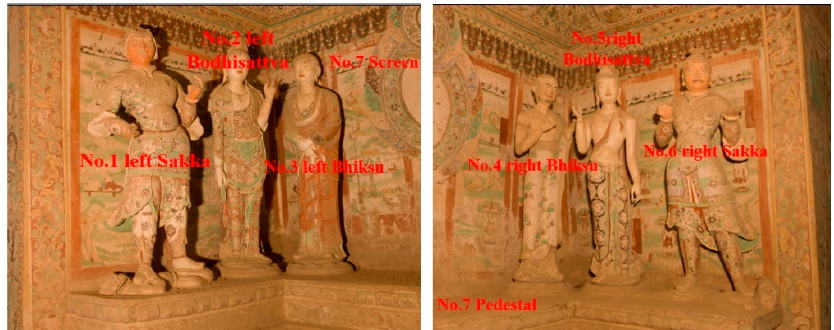
Figure 2. Scanning order of the niche area.